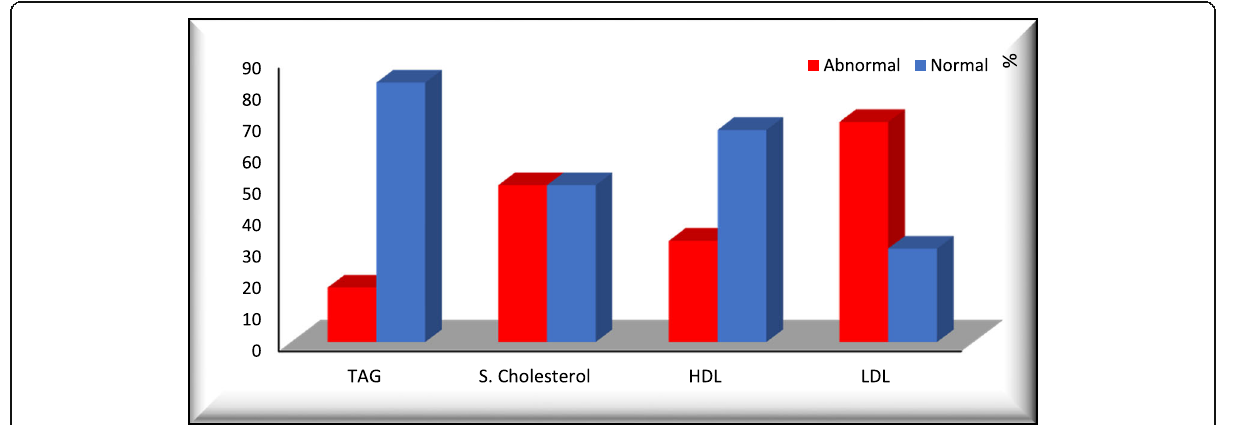
Fig. 1 Distribution of different parameters of lipid profile among included patients with Behçet ’ s disease ( n =